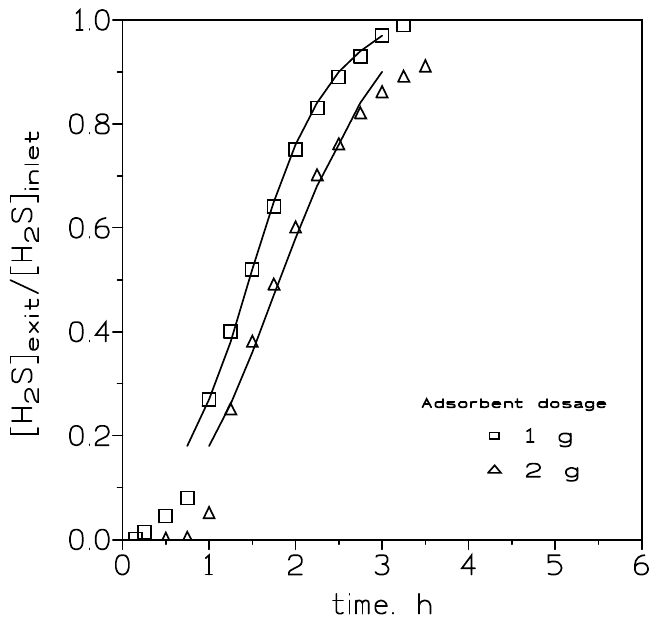
Figure 1. Experimental (points) and model (lines) breakthrough curves at various adsorbent dosages. H 2 S dosage: 400 mg. Gas flow: 210 cm 3 /min. Temperature: 20 °C.